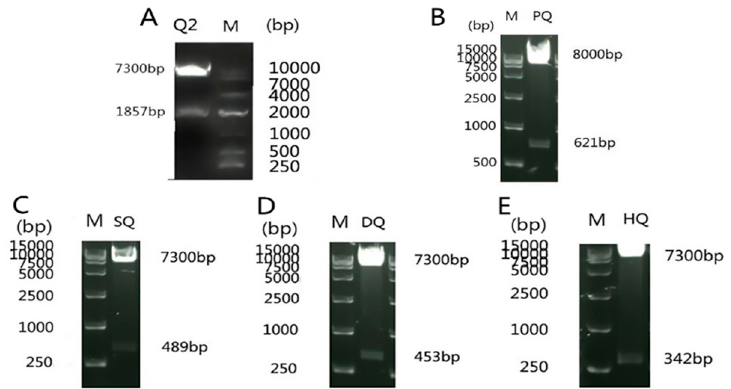
Figure 1. Identification of double enzyme digestion of pGBKT7-NS3, pGADT7-PRDX1, pGBKT7-S7, pGBKT7-DEXDc, and pGBKT7-HELICc: ( A ) bait plasmid pGBKT7-NS3, ( B ) prey plasmid pGADT7-PRDX1, ( C ) bait plasmid pGBKT7-S7, ( D ) bait plasmid pGBKT7-DEXDc, and ( E ) bait plasmid pGBKT7-HELICc.